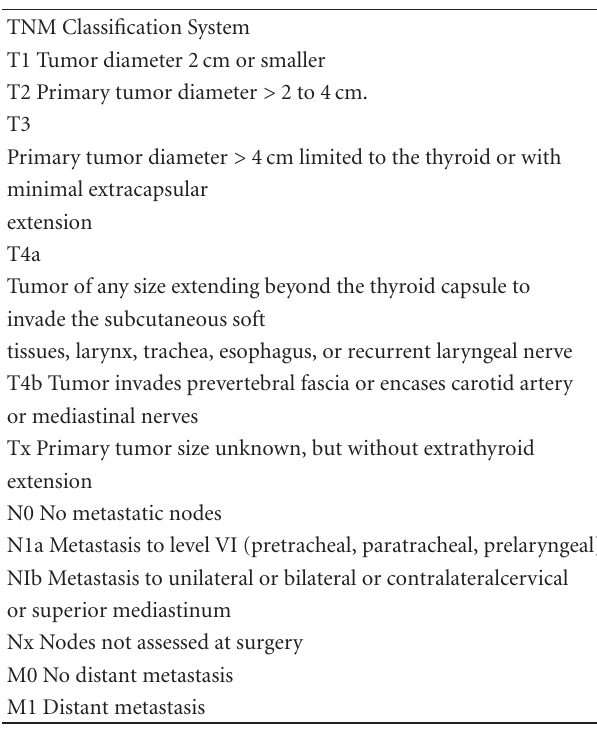
Table 4: TNM classification system for thyroid